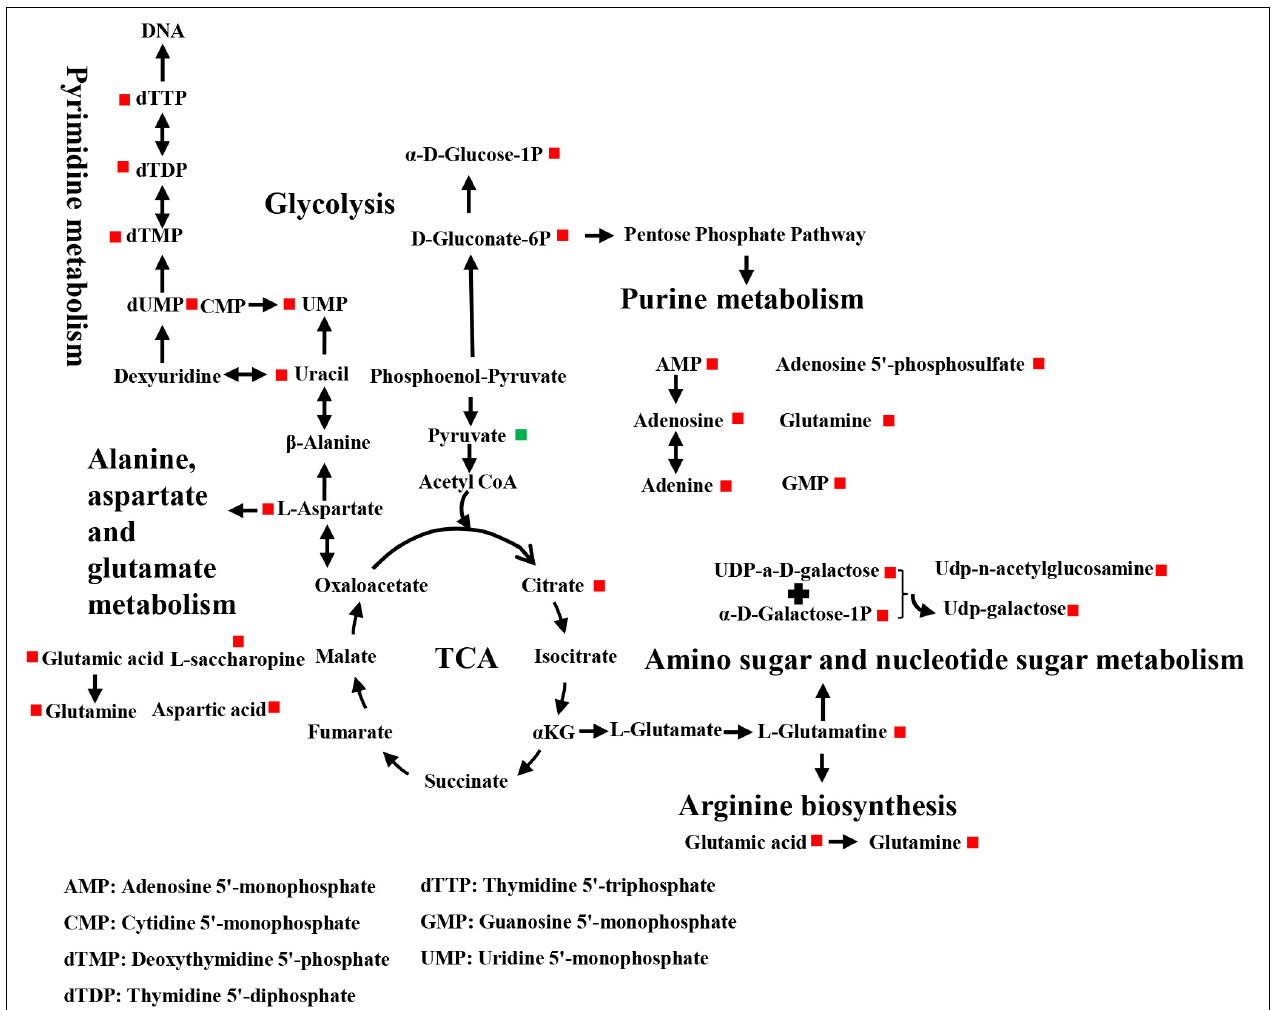
FIGURE 7 | Schematic representation of altered metabolic pathways in LMH cells infected with FAdV-4.